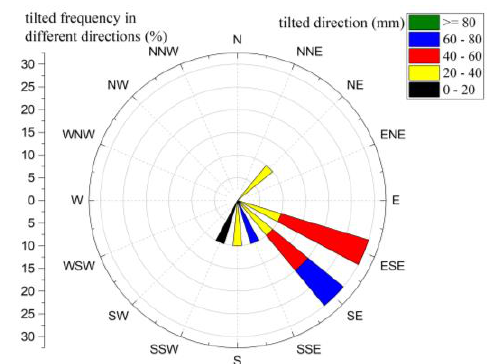
Figure 11 . A wind rose graph of the columns on the third floor